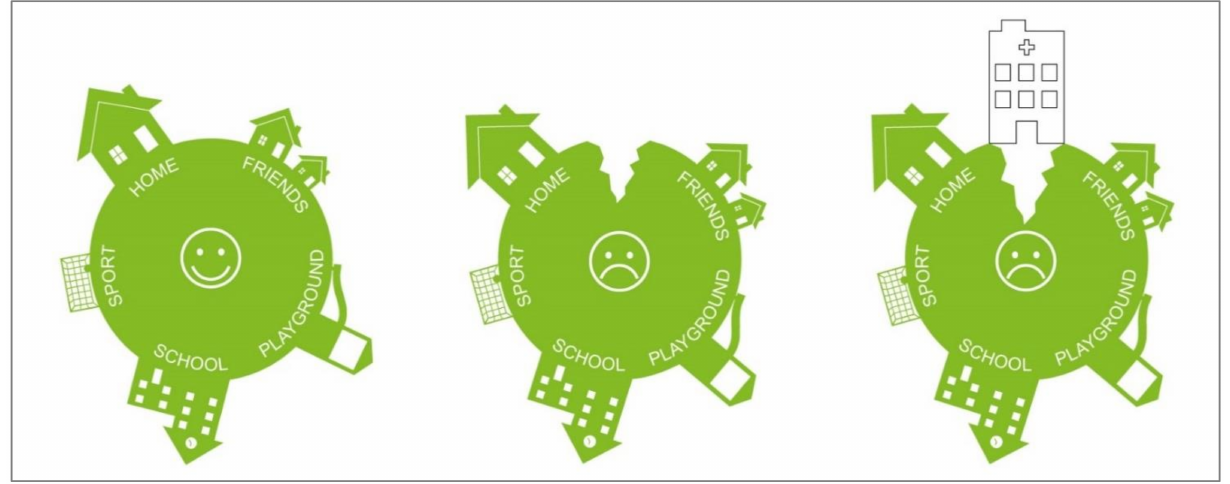
Figure 4. Graphical depiction of the emergence of the parent–child patient [90].